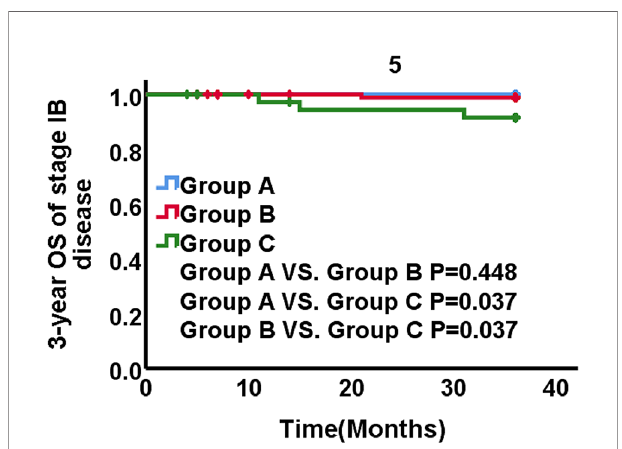
FIGURE 5 | OS strati fi ed by three groups for patients with stage IB1-IB3 disease.